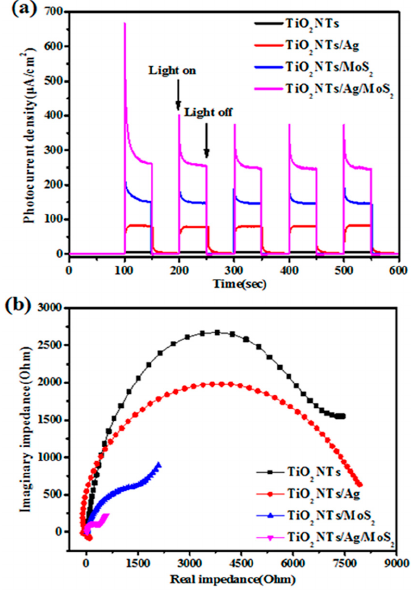
Figure 8. ( a ) Photocurrent responses; ( b ) electrochemical impedance spectroscopy (EIS) Nyquist plots of TiO 2 NTs, TiO 2 NTs/Ag, TiO 2 NTs/MoS 2 , and TiO 2 NTs/Ag/MoS 2 .